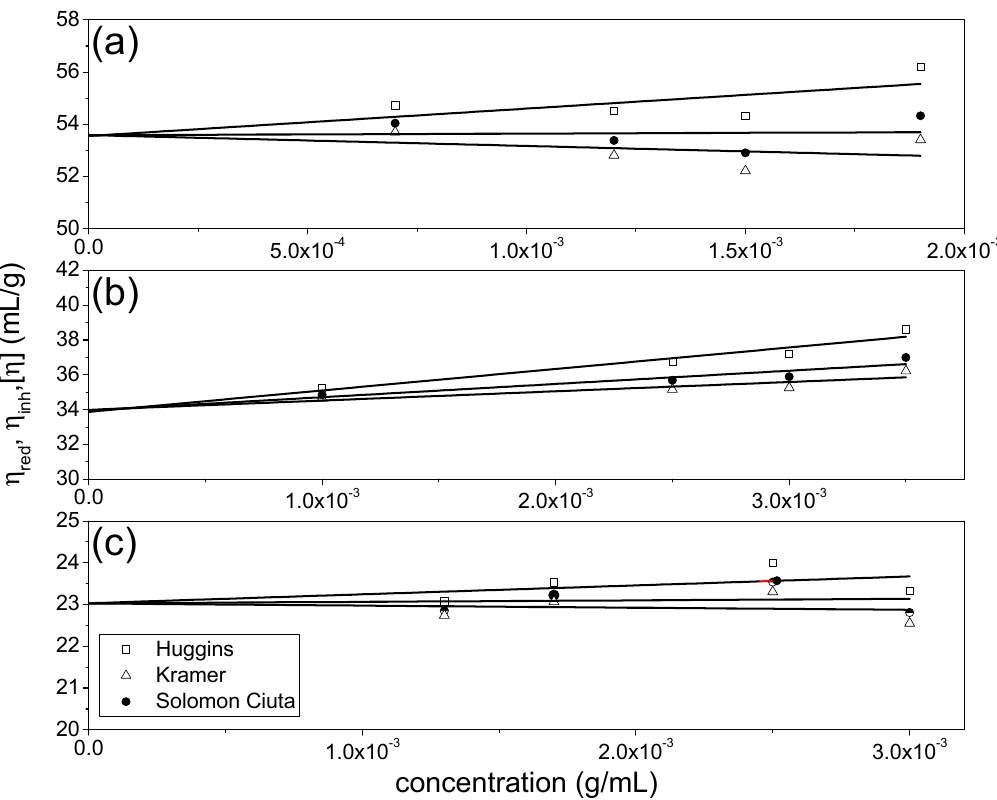
Figure 1. Intrinsic viscosity plots of Curcurbita moschata polysaccharides ( a ) NJBTF1, ( b ) NJBTF2, ( c ) NJBTF3. □ : reduced viscosities, η red , fitted by the Huggins equation; ∆ : inherent viscosities, η inh , fitted by the Kraemer equation; ● : Solomon-Ciuta estimates ([ η ] sc ) with a linear extrapolation to c = 0. Solvent: phosphate chloride buffer (pH 7.0, I = 0.1 M), temperature = 20.0 °C. Table 1. Intrinsic viscosity of C. moschata polysaccharide fractions.